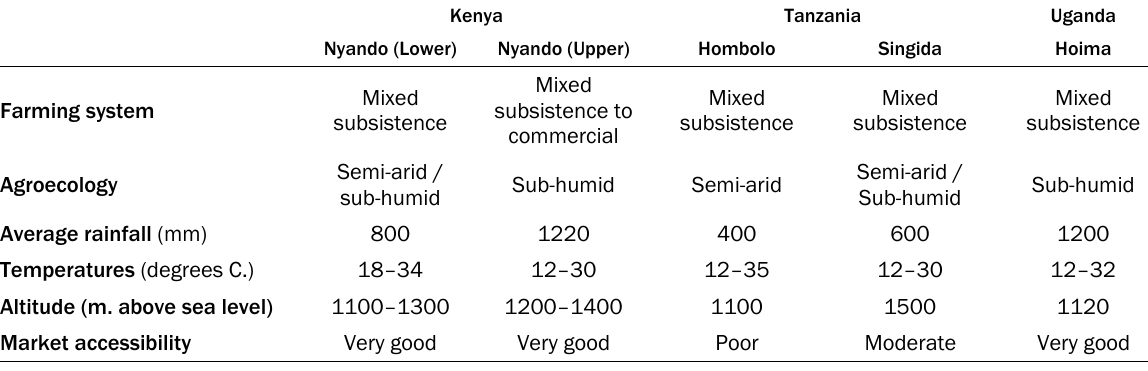
Table 1. Summary Information for the Study Sites in Kenya, Tanzania, and